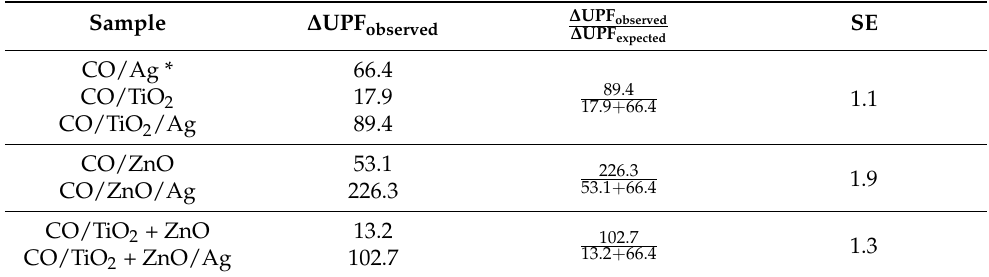
Table 3. Calculated ∆ UPF observed and SE between the components in the unwashed composite